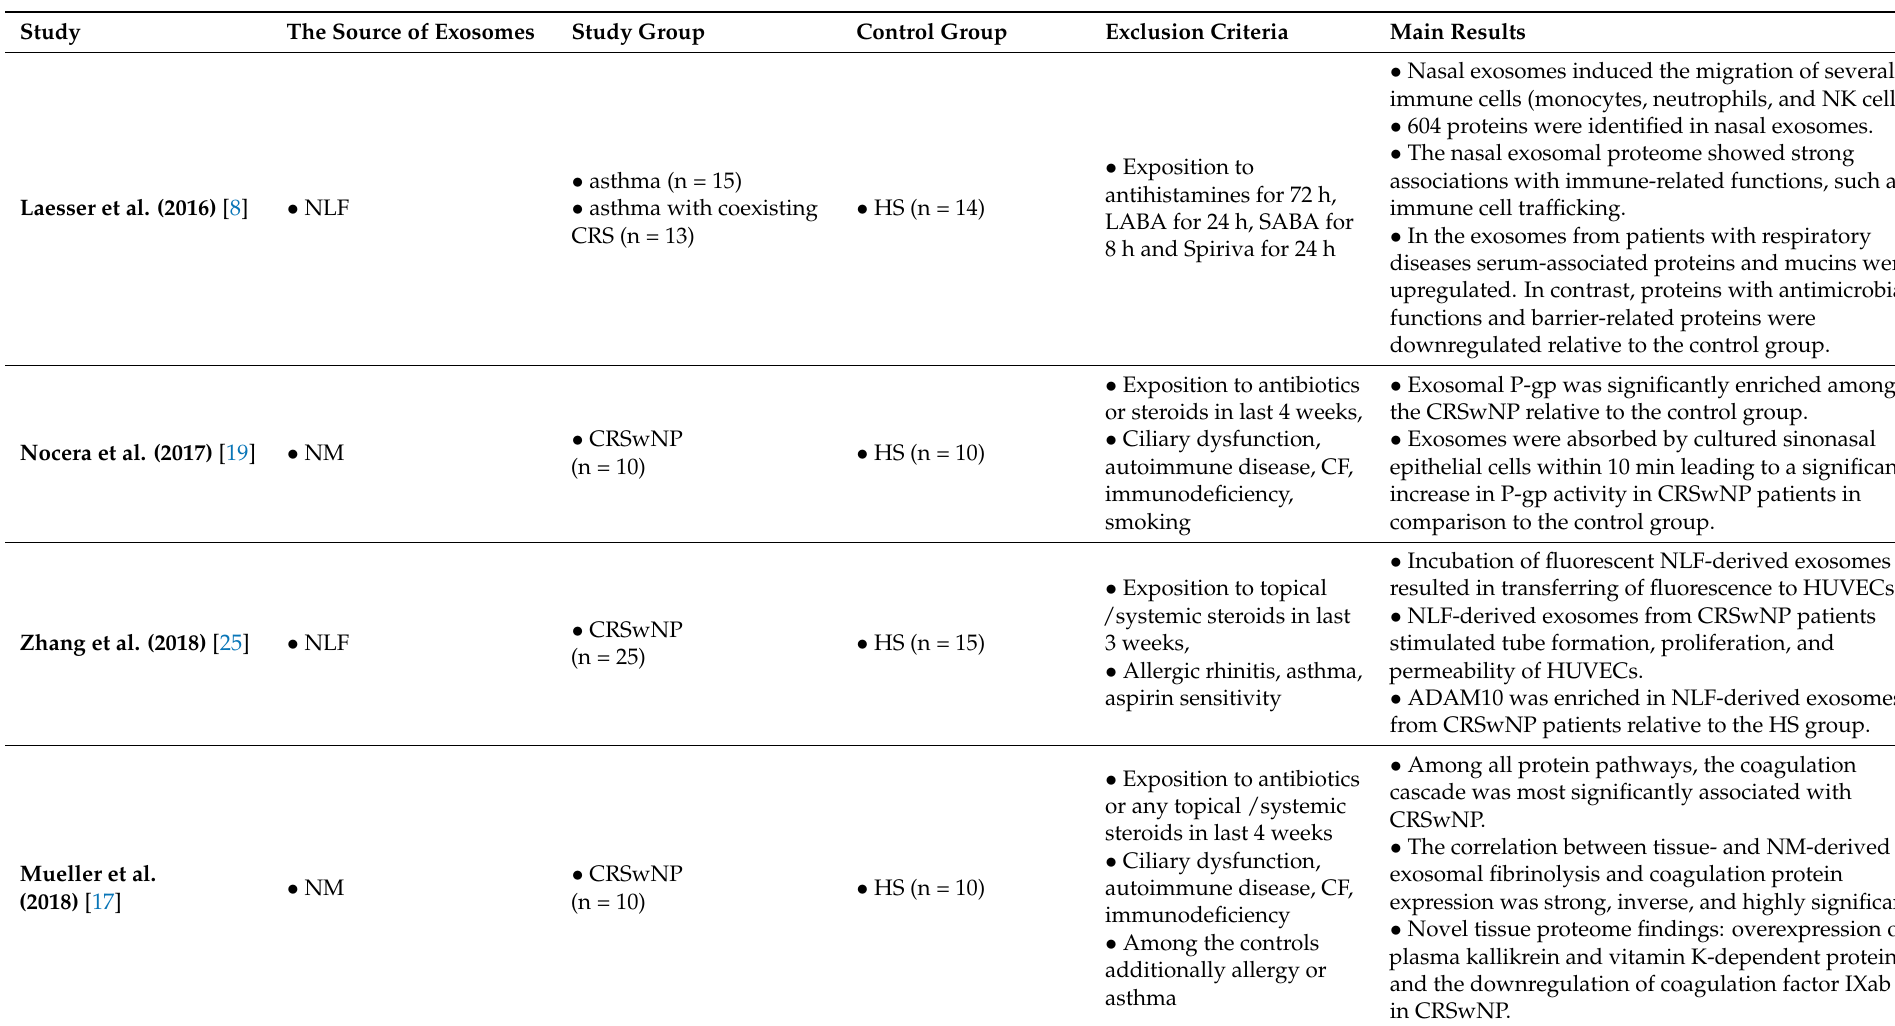
Table 2. Characteristics of studies included in the systematic